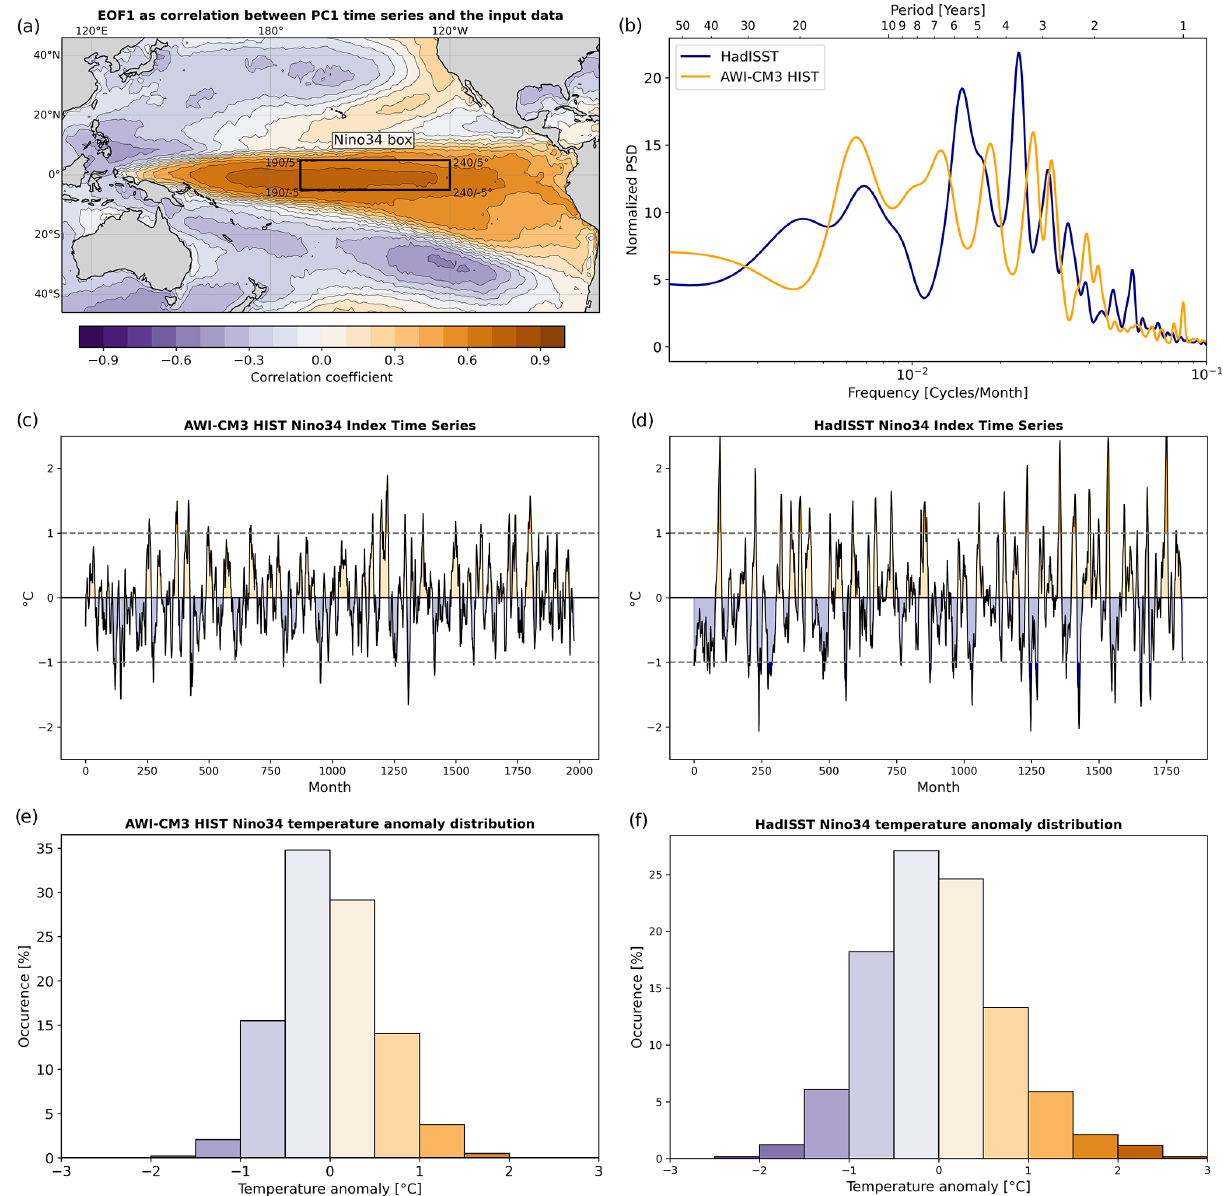
Figure 9. (a) Extent of the Niño 3.4 box, as well as the first empirical orthogonal function expressed as the correlation between the first principal component and the input dataset at each point in space. Calculated from the entire HIST simulation using the EOF toolbox (Daw- son, 2016). (b) Normalized power spectrum density of simulated ENSO within the Niño 3.4 box in comparison to HadISST observational estimates for the years 1850 to 2014. (c, d) Niño 3.4 SST index defined as the detrended seasonal cycle removed and 3-month running mean time series of SST averaged over the Niño 3.4 box. The results from AWI-CM3 HIST and HadISST observational estimates are shown, respectively. (e, f) As (c) and (d) but depicting occurrence of temperature anomalies in bins with a width of 0.5 ◦